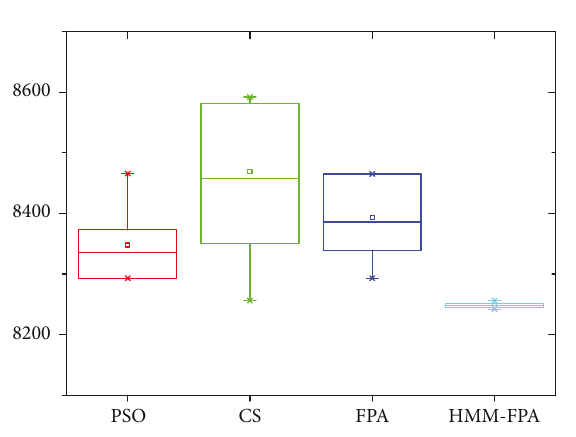
Figure 5: ANOVA tests of Car2.